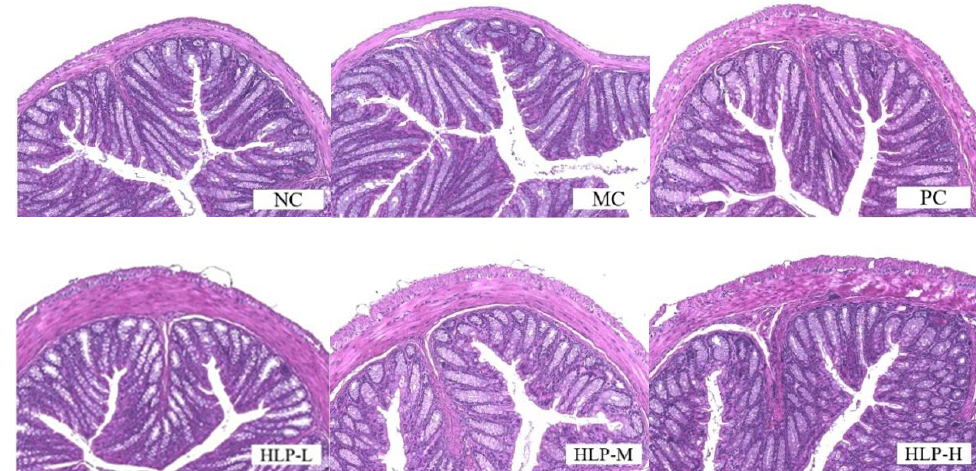
Figure 2. Pathological sections of colon tissue by hematoxylin and eosin (H&E) staining (200× magni- fication). NC: normal control group, MC: model control group, PC: positive control group, HLP-L: low-dosage HLP group, HLP-M: middle-dosage HLP group, and HLP-H: high-dosage HLP group. Mice